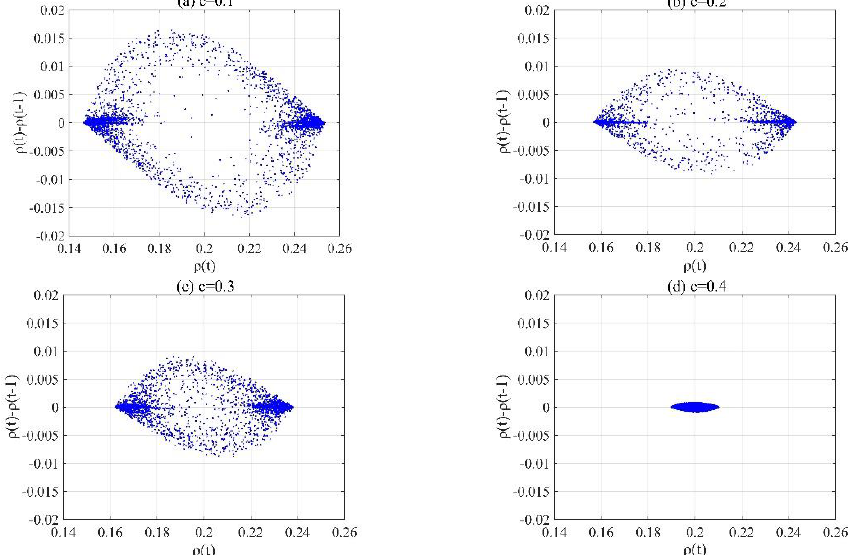
Figure 6. Plots of density versus density difference corresponding to Figure 4.